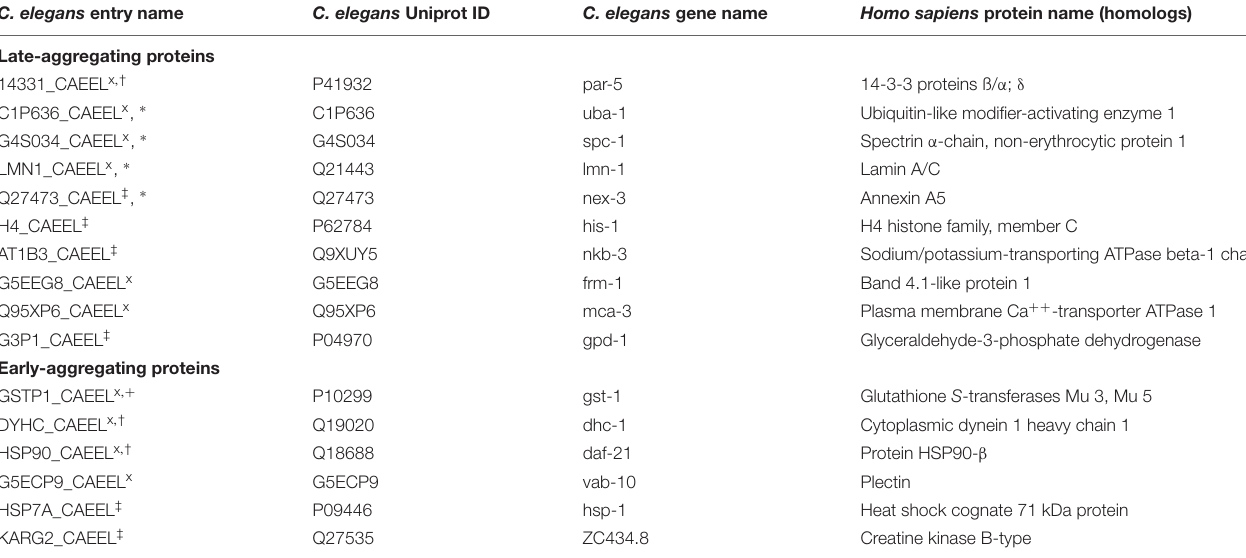
TABLE 2 | Minor components of AD pathological aggregates identified as late- or early-aggregating proteins in C. elegans